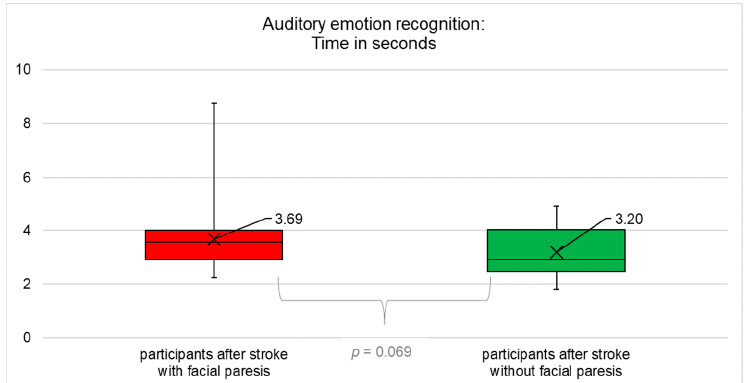
Figure 4. Average time taken for auditory emotion recognition (mean, median, interquartile range). Participants after stroke with facial paresis did not differ significantly compared to participants after stroke without facial paresis ( p = 0.069).